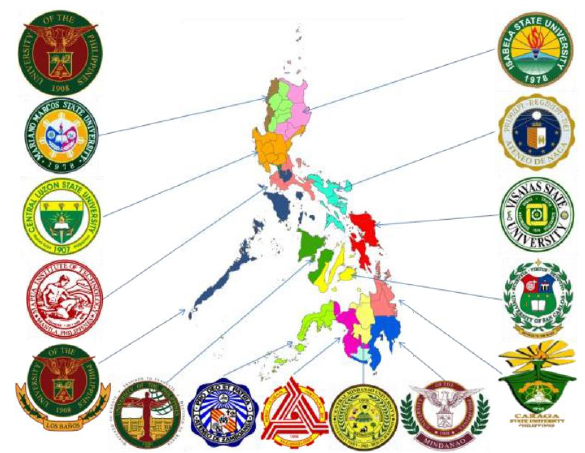
Figure 1. Implementing Institutions and Area